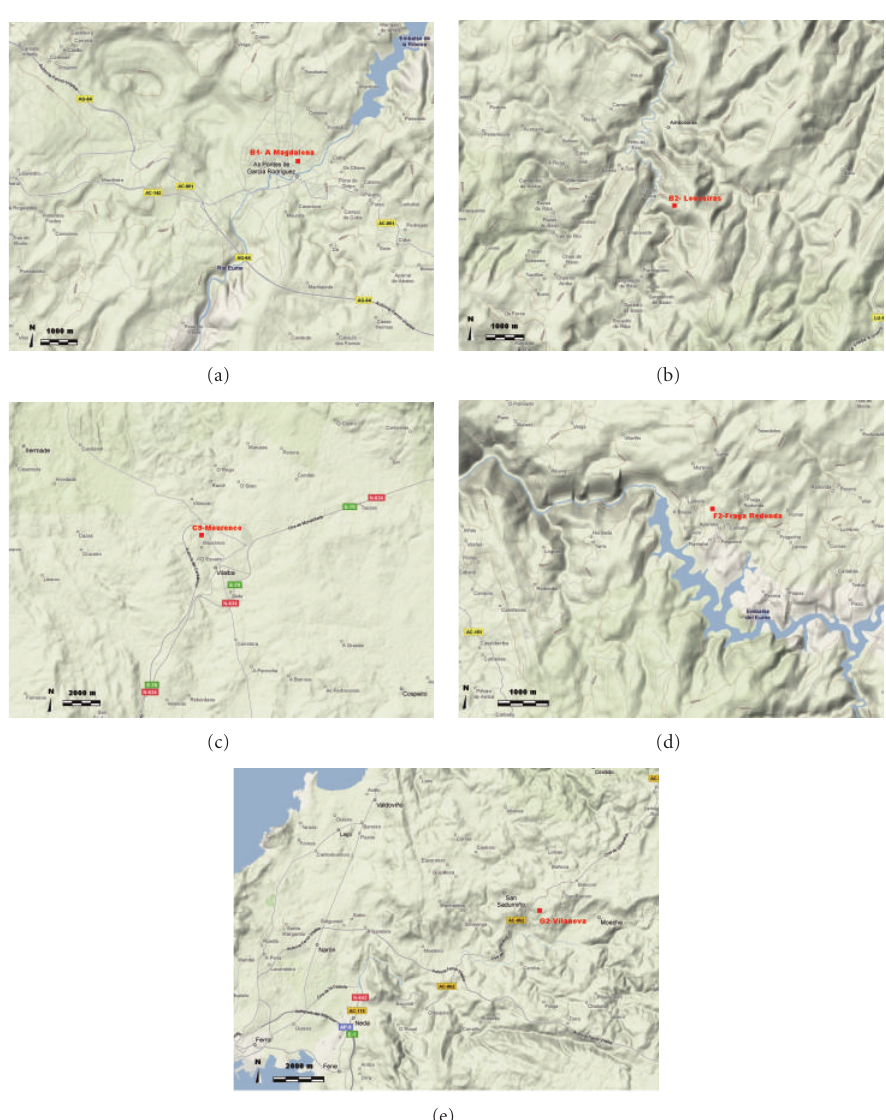
Figure 3: Geographic location and topography of the analyzed Galician air quality